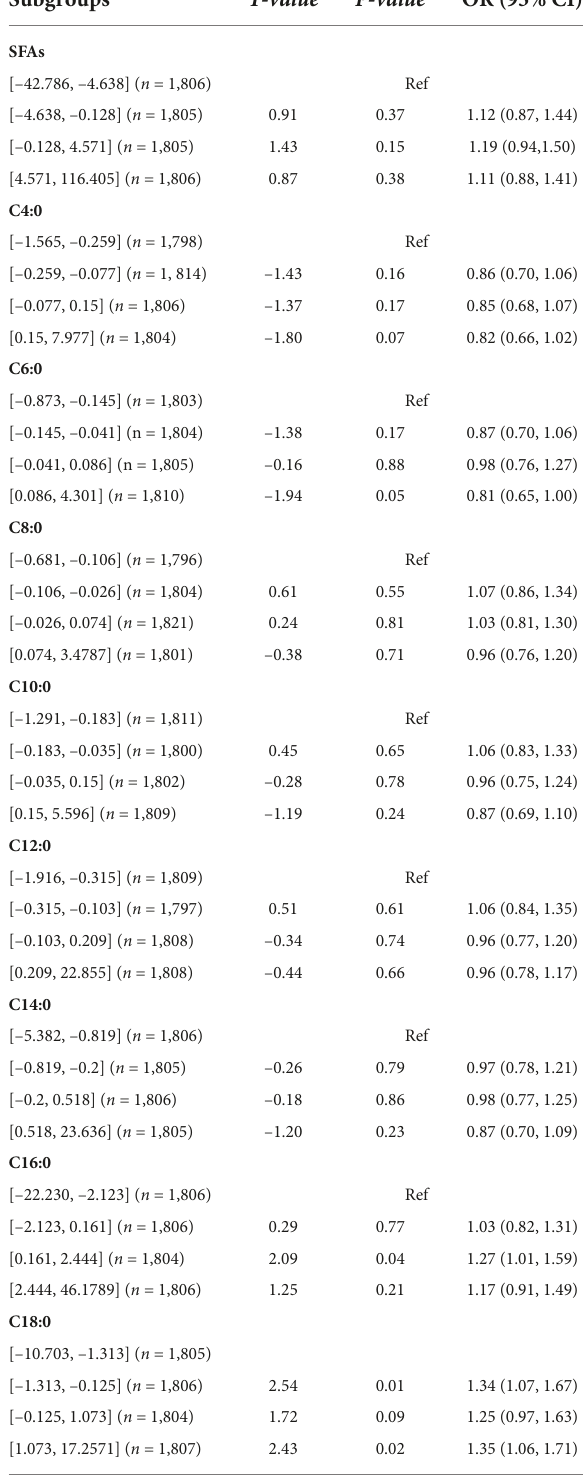
TABLE 4 Univariate logistic regression results of the relationship between saturated fatty acids and their subtypes and hypertension. Subgroups T-value